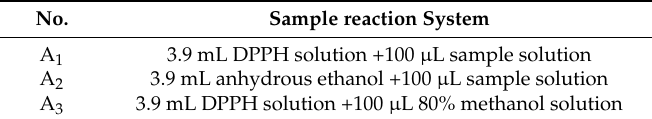
Table 1. DPPH (2,2-Diphenyl-1-picrylhydrazyl) determination method.